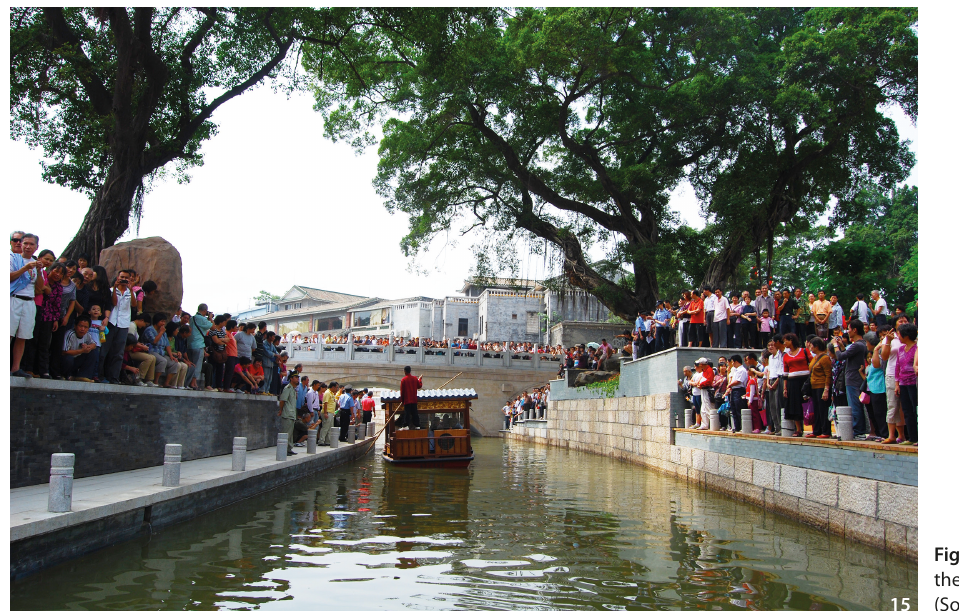
Figure 15 Citizens gathered to the canal on the opening day (Source: Guoxiang Huang).